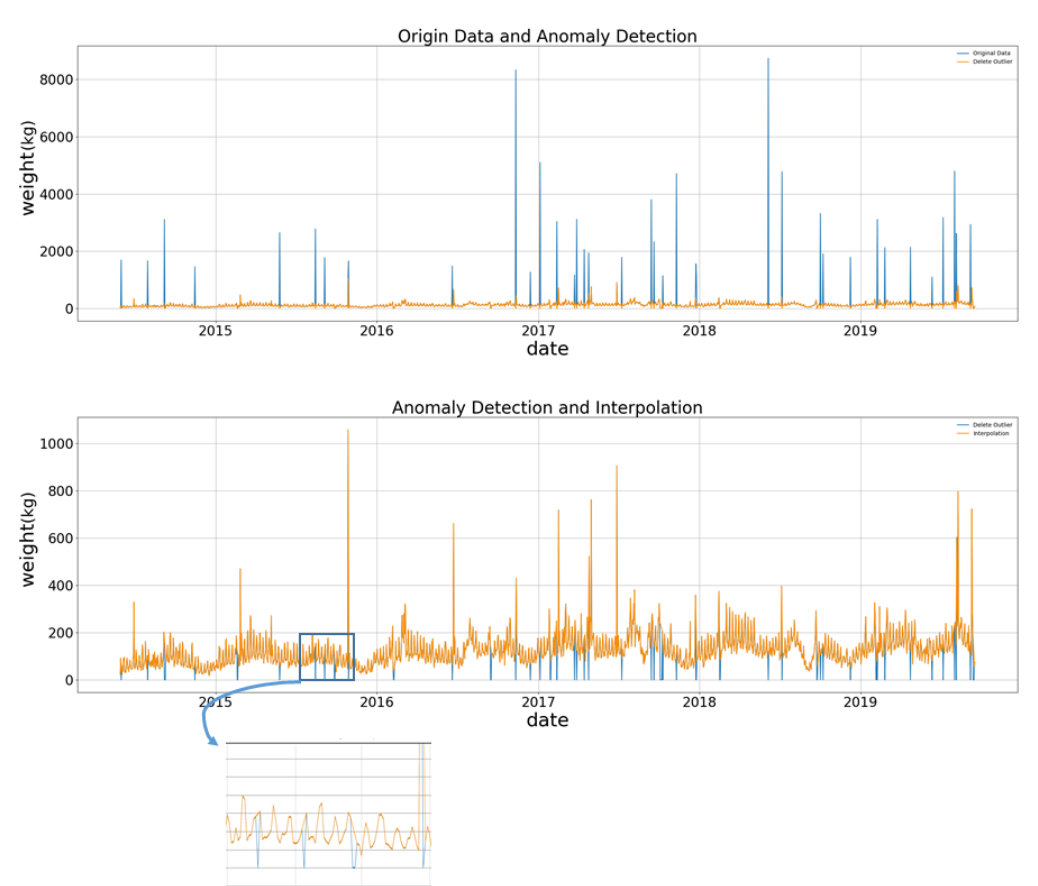
Figure 5. In the ( top ) plot, the blue and orange lines are the raw data and the data after removing outliers, respectively. The ( bottom ) plot shows that the missing values (blue line) of the orange line are interpolated; a part of the bottom plot is also enlarged and shown.